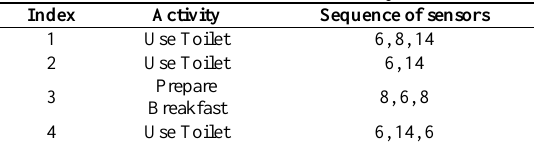
Table 5. Sequence of sensors in ascending activation time order for each activity.